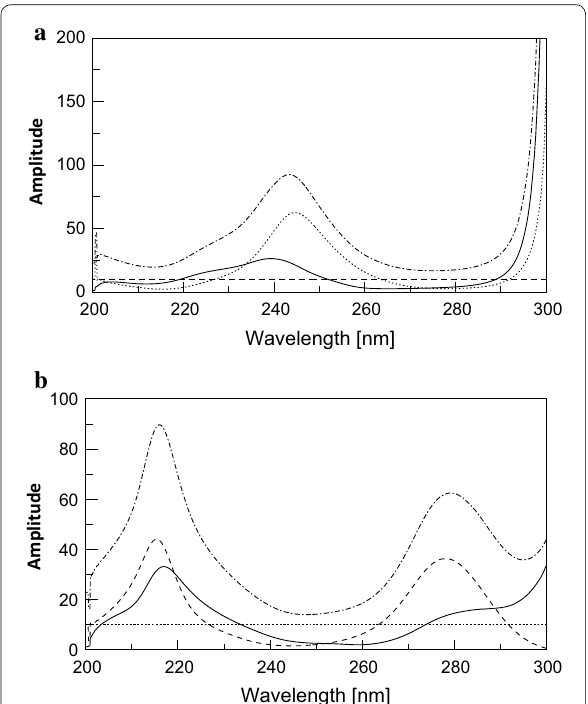
Fig. 9 a Ratio spectra of DRO ( solid line ), CAF ( dashed line ), PCT ( dotted line ) and their ternary mixture ( dashed dotted line ) contain- ing 10 μg/mL of each using normalized CAF spectrum as a divisor. b Ratio spectra of DRO ( solid line ), CAF ( dashed line ), PCT ( dotted line ) and their ternary mixture ( dashed dotted line ) containing 10 μg/mL of each using normalized PCT spectrum as a divisor